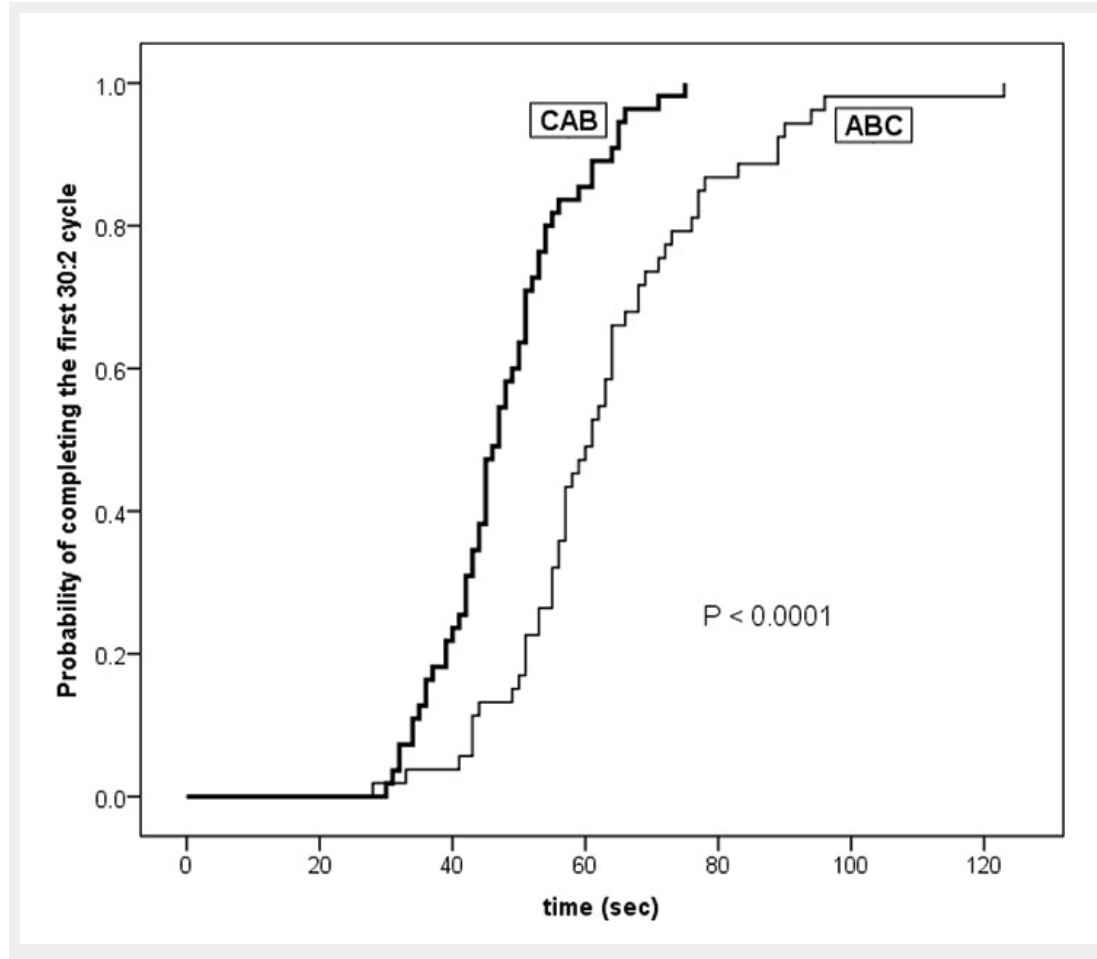
Figure 3 Kaplan-Meier diagram displaying the probability of completing the first resuscitation cycle consisting of 30 compressions and 2 ventilations over time. Teams were randomized to apply either ABC or CAB as initial approach to CPR. Time 0 is defined as first touch of the patient by one of the rescuers. Curves differ significantly (log-rank